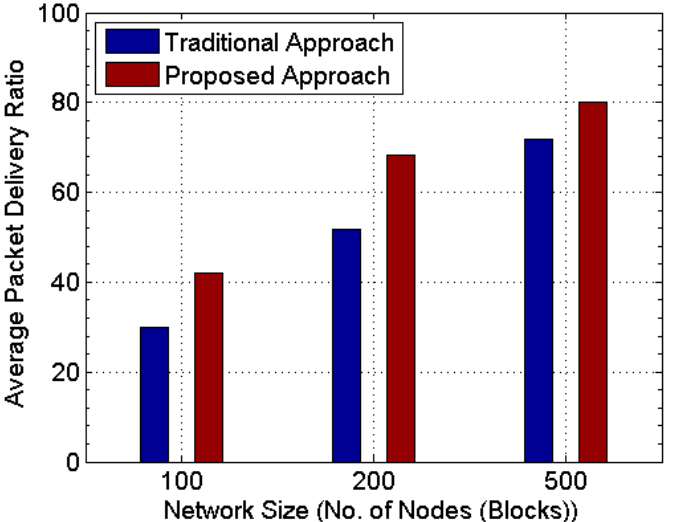
Figure 4. Comparison of average Packet Delivery Ratio (PDR) for the traditional approach and proposed approach.